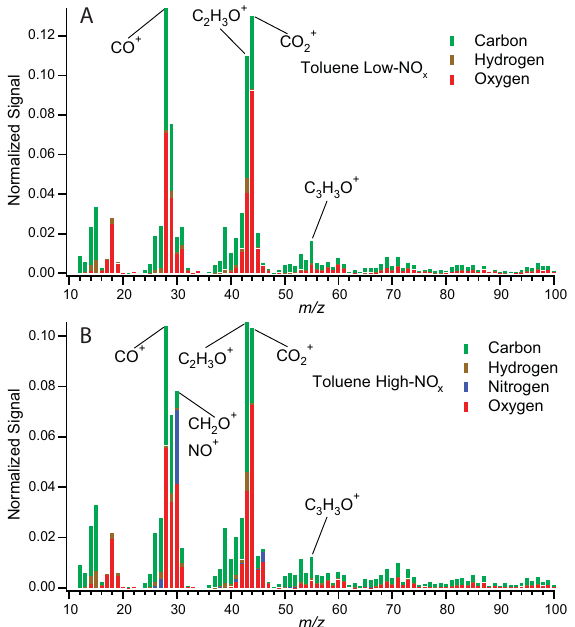
Fig. 10. High-resolution mass spectra of m -xylene SOA formed un- der low-NO x (A) and high-NO x (B) conditions with elemental con- tributions to each mass-to-charge ratio shown. Spectra were taken at the peak of SOA growth.